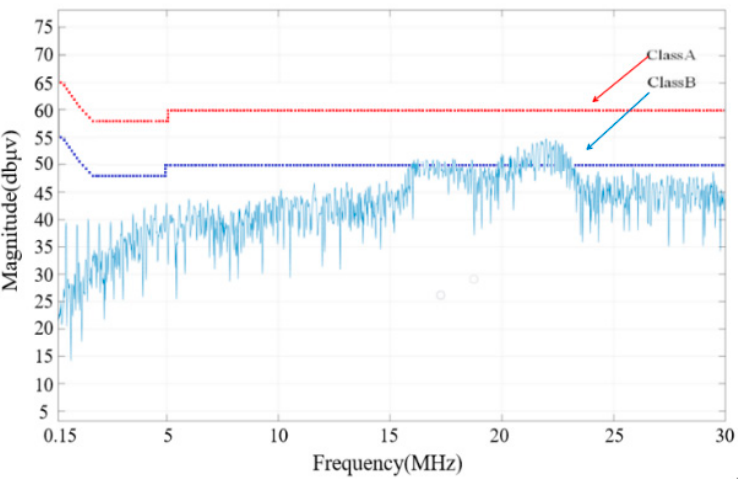
Figure 17. Three-module parallel DC-side CM interference.